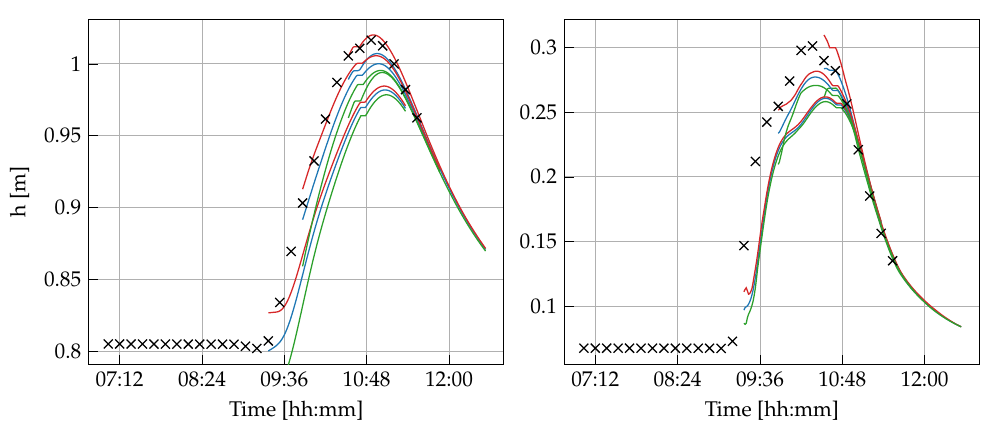
Figure 11. Water level prediction at the locations of Sensor B ( left ) and Sensor C ( right ) at three time instances compared with the measurements from Sensors B and C, respectively. The measurements are marked in black, while the minimal (green), mean (blue) and maximal (red) water level are obtained from the model